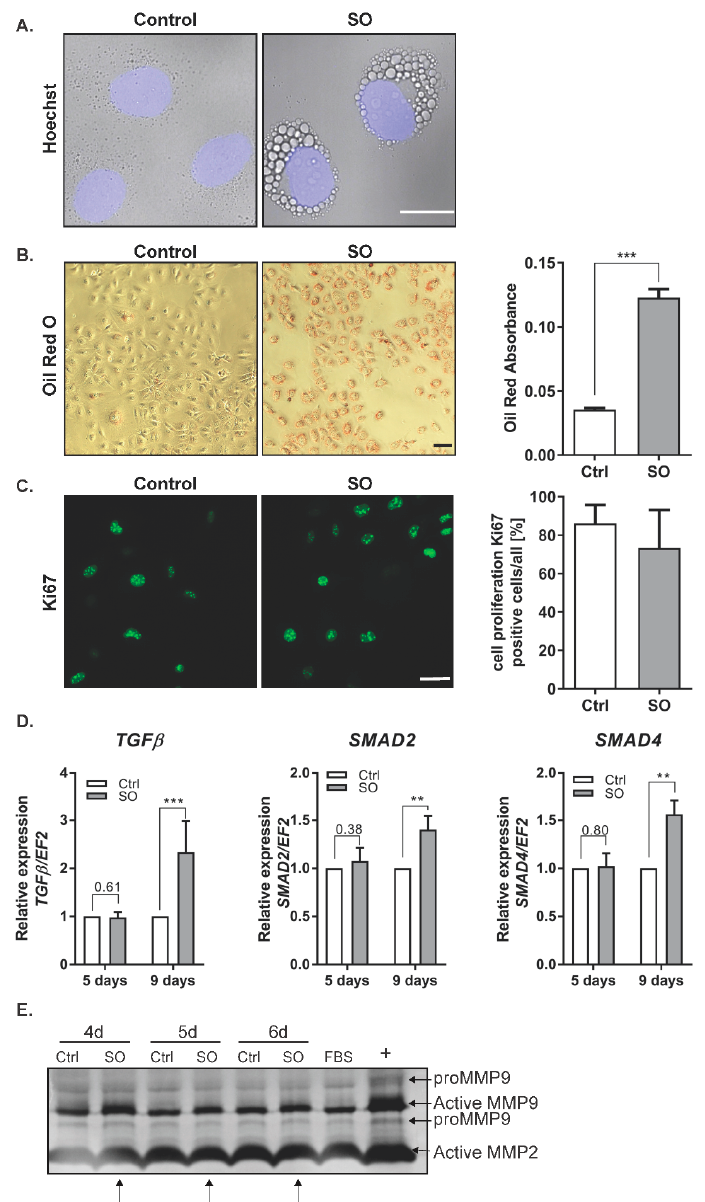
Figure 1. The influence of sodium oleate on the Huh7 cells phenotype. ( A ) Changes in morphology (63 × magnification, Hoechst for nuclei, scale bar: 20 µ m), SO—0.5 mM sodium oleate. ( B ) Oil Red O staining of the Huh7 cells stimulated for 24 h with 0.5 mM sodium oleate (SO) (representative pictures, 10 × magnification, scale bar: 50 µ m), The graph shows the differences in fat accumulation by control and stimulated cells. ( C ) Immunofluorescence staining of the proliferation marker Ki67 (representative images, magnification 63 × , scale bar: 50 µ m). The chart represents the ratio of positive cells compared to whole cells from five fields of view, n = 100, SO—0.5 mM sodium oleate. ( D ) mRNA expression of TGF β , SMAD2, SMAD4 after five and nine days of sodium oleate stimulation. Analysis of TGF β was conducted in six independent experiments, analysis of SMAD2 and SMAD4 in three independent experiments; mRNA level in each sample was analyzed in duplicates. The mRNA level in the control was set to 1. The EF2 gene was used as reference. ( E ) MMP2 and MMP9 levels after four, five, and six days of sodium oleate stimulation. The image of the gel shows the pro-form and active form of MMPs. The medium from the Caki-1 cell-stimulated phorbol myristate acetate (PMA) was used as the positive control (+), arrows indicate an increase of activity; Ctrl—control, SO—0.5 mM sodium oleate. The results are presented as the means ± SD, the Student’s t -test was used to determine the p -value, ** p < 0.01, *** p <